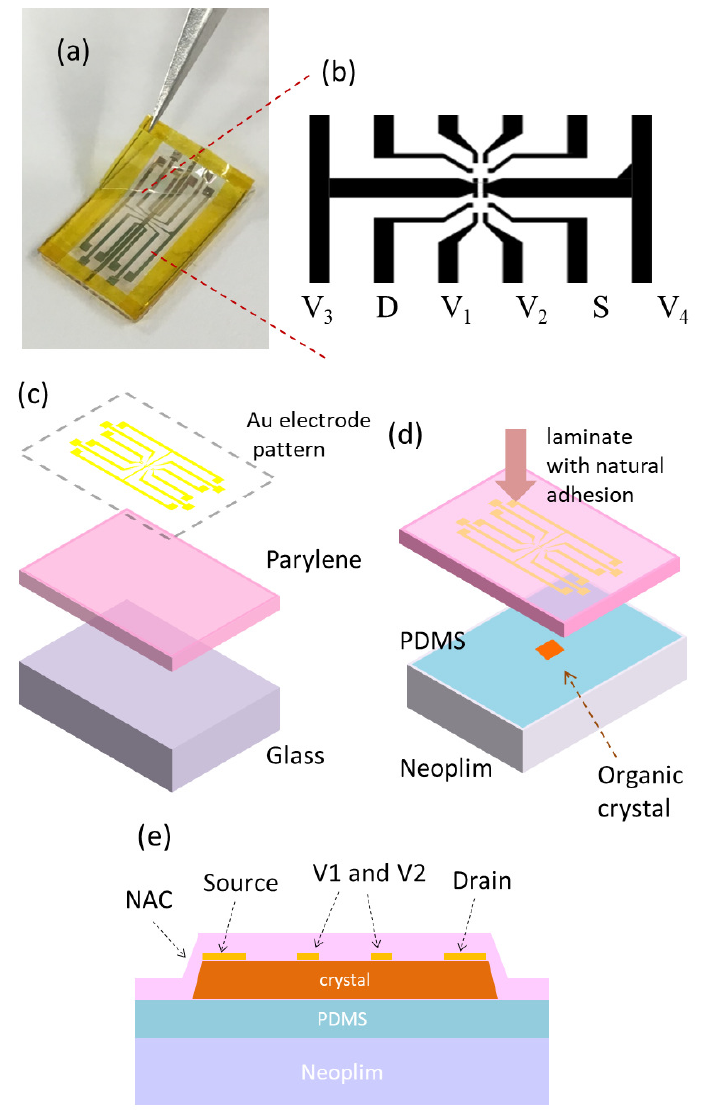
Figure 1. ( a ) Photograph of NAC during the process of being peeled off the preparation substrate. ( b ) Magnified view of the center of the NAC pattern. D and S denote the drain and source electrodes used as the current application electrodes in four-probe measurements. V 1 –V 4 denote the electrodes for measurement of the electrical potential. Illustrations of ( c ) the NAC structure and ( d ) the sample. The NAC is prepared on the glass substrate, peeled off, and then laminated onto the organic crystal using natural adhesion. ( e ) Cross-sectional view of the